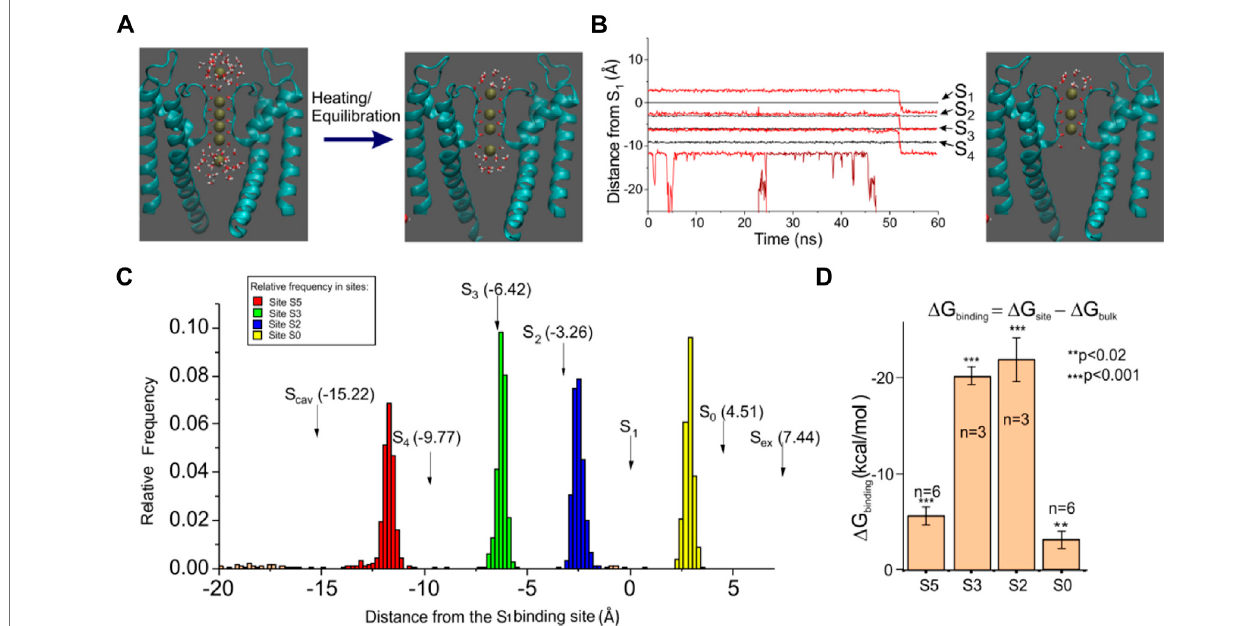
FIGURE2| MoleculardynamicsoftheKcsAchannel. (A) left: KcsAstructureandinitialK + ioncon fi gurationusedinourMDsimulations.K + ionswereplacedinsites S1 – S4 inside the selectivity fi lter, at the cavity, and in the site S ex found in X-ray crystallography. Right: typical ion con fi guration found after heating and equilibration. (B) left: plot of the K + ion position as a function of time for one typical MD simulation. The black lines represent the position of the four SF crystallographic sites (assessed as the center of mass of the eight carbonyl oxygens) while the red lines represent the position of the K + ions. Right: SF con fi guration found at 50 ns, with only three K + ionsboundtotheSF. (C) amplitudehistogramoftheK + ionpositionassessedfroma400nslongMDsimulation,showingfourpreferentialpositions.Thearrowsindicate the K + binding sites found in the high-resolution structure. (D) binding free energy assessed using the free energy perturbation technique for the four K + binding sites found to be typically occupied in our simulations. The plot reports the difference between the free energy variation obtained following the annihilation of a K + ion in water ( Δ G bulk )andaK + ionsittinginabindingsite( Δ G site ).Intheinitialcon fi guration,shownontheleftofpanelA,ionswereconstrainedwithin+/-1 (cid:1) Afromthebindingsiteusing a collective variable approachofNAMD. Since the application ofaconstraint adds an entropy term tothe freeenergy variation (Wang et al.,2006),the same constriction was also applied to the bath K + ion, in order to have the same effect on all free energy values presented.